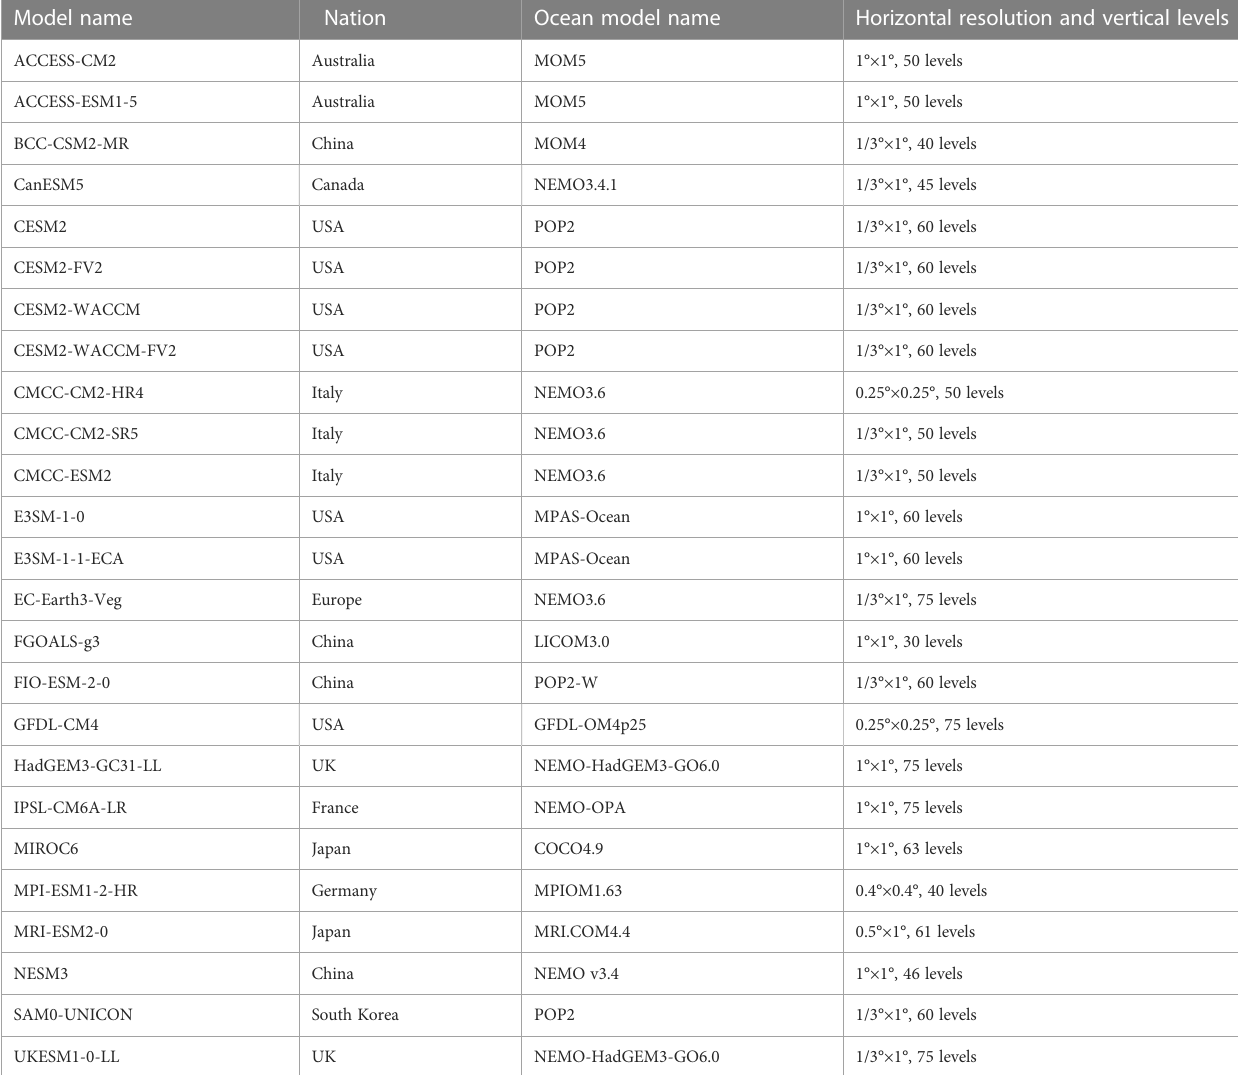
TABLE 2 Basic information of the 25 CMIP6 coupled models used in this